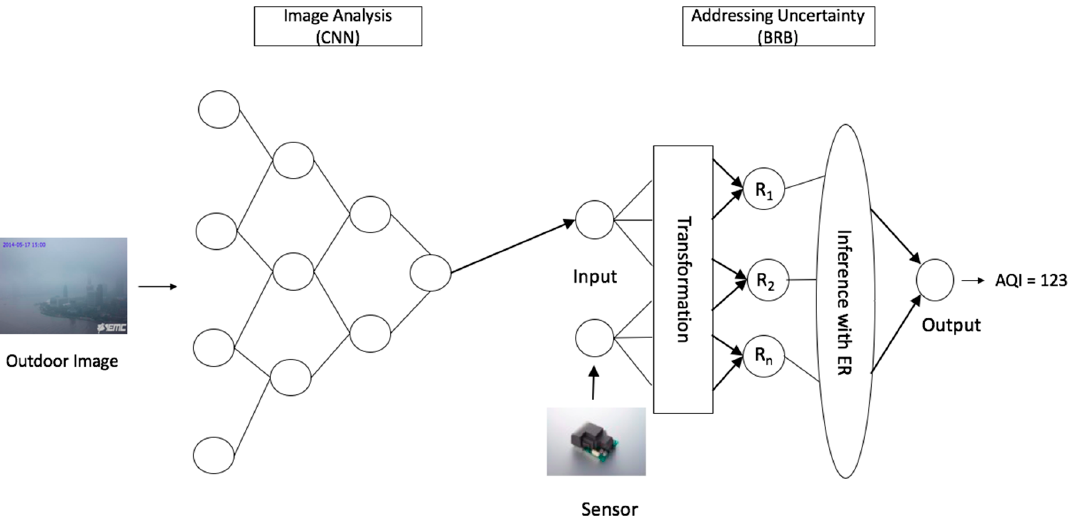
Figure 1. System Figure 1. System Architecture.